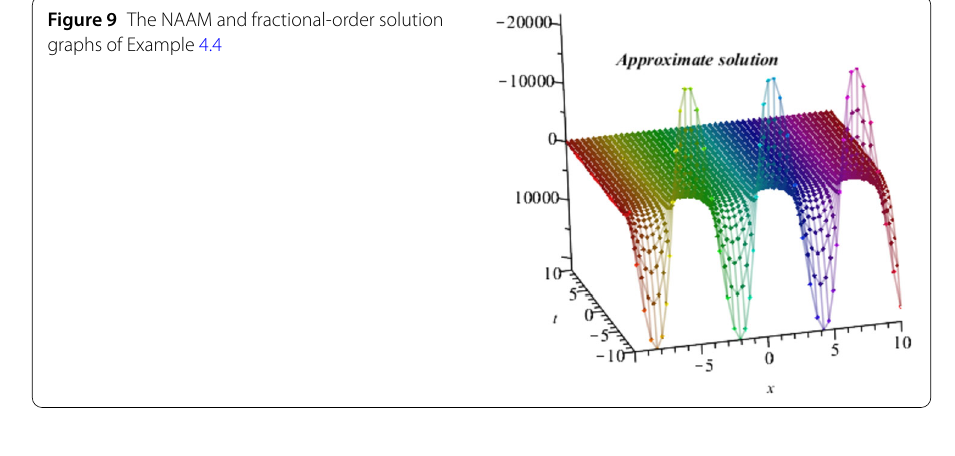
Figure 10 The different fractional-order graph of Example 4.4